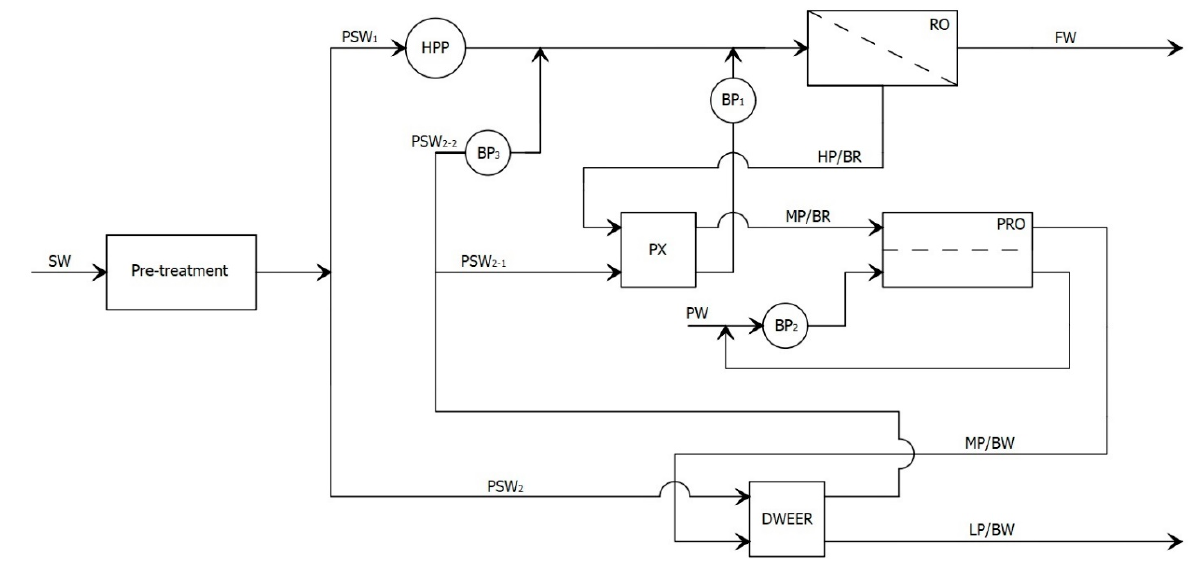
Figure 7. Schematic diagram of the selected RO-PRO hybrid desalination process for an arid urban area.